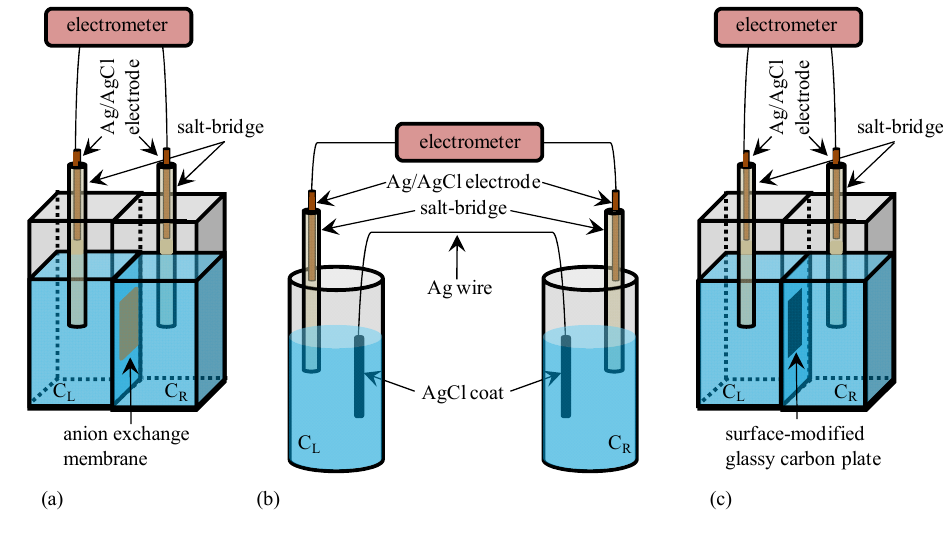
Figure 1. Experimental setup for measuring the potential between two KCl aqueous solutions separated through the intermediary of ( a ) a anion exchange membrane; ( b ) an Ag wire; and ( c ) a surface-modified glassy carbon plate KCl concentrations in the left and and C , respectively, for all the right compartments are represented by C L R